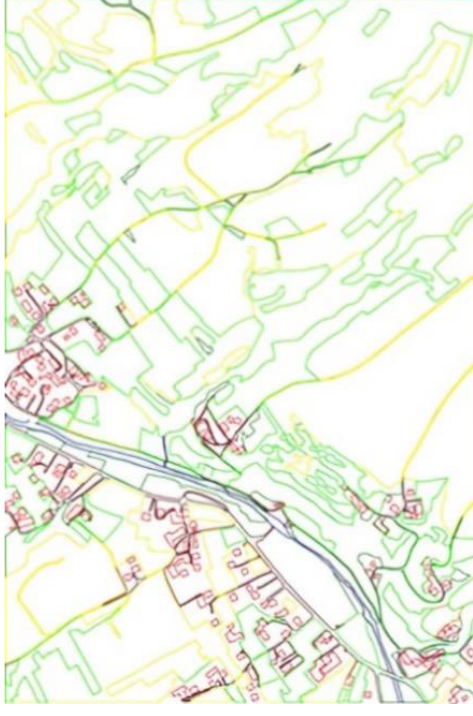
Figure 7. The image created after the vectorization of the orthophotomap from 1963.